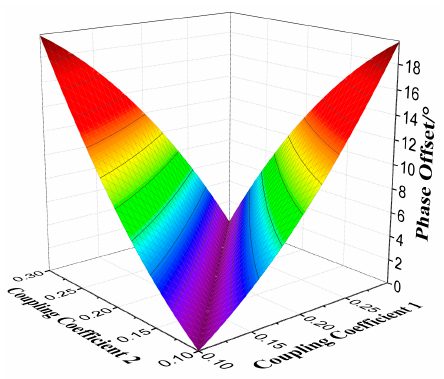
Figure 4. Phase offset φ under the change of mutual inductance in DEU-WPT system.